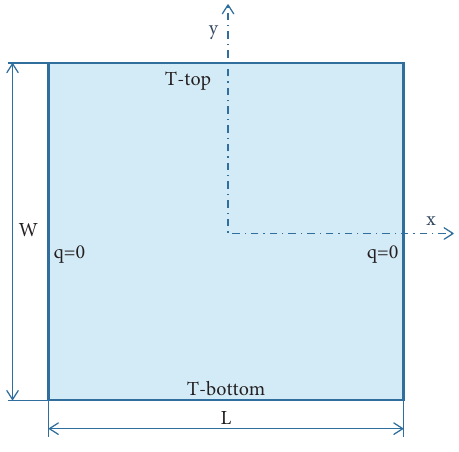
Figure 6: Model geometry of square plate. Table 1: Material properties and dimensions.